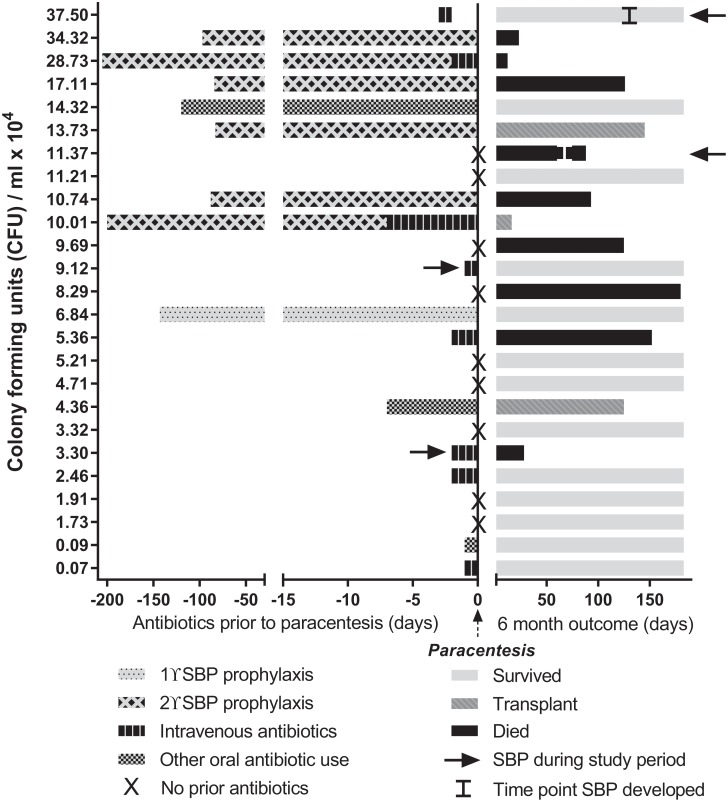
Ascites cohort antibiotic history and 6-month outcomes.Antibiotic treatment history prior to the study paracentesis and 6 month outcomes are depicted for each patient, in relation to their ascitic bacterial DNA burden (CFU/ml).